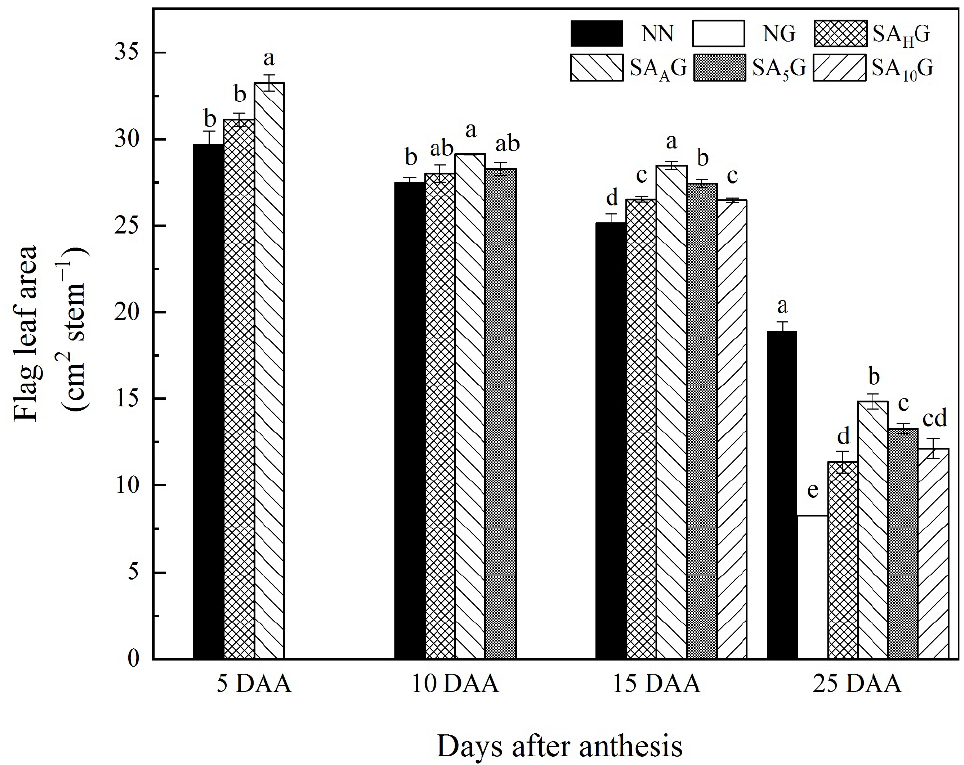
Figure 3. Effects of exogenous salicylic acid (SA) spraying on the flag leaf area of wheat under high temperature stress at the grain-filling stage in 2018–2019. NN is the control (normal growth conditions outside the shed). NG represents non-SA spraying and high temperature stress at the grain- filling stage. SA H G represents exogenous SA spraying at the heading stage and high temperature stress at the grain-filling stage. SA A G represents exogenous SA spraying at the anthesis stage and high temperature stress at the grain-filling stage. SA 5 G and SA 10 G represent treatments whereby exogenous SA was sprayed starting from 5 and 10 DAA and high temperature stress at the grain- filling stage. Different lowercase letters denote statistically significant differences ( p < 0.05, Duncan’s multiple range test) among treatments. Results are expressed as mean ± SE ( n = 3).